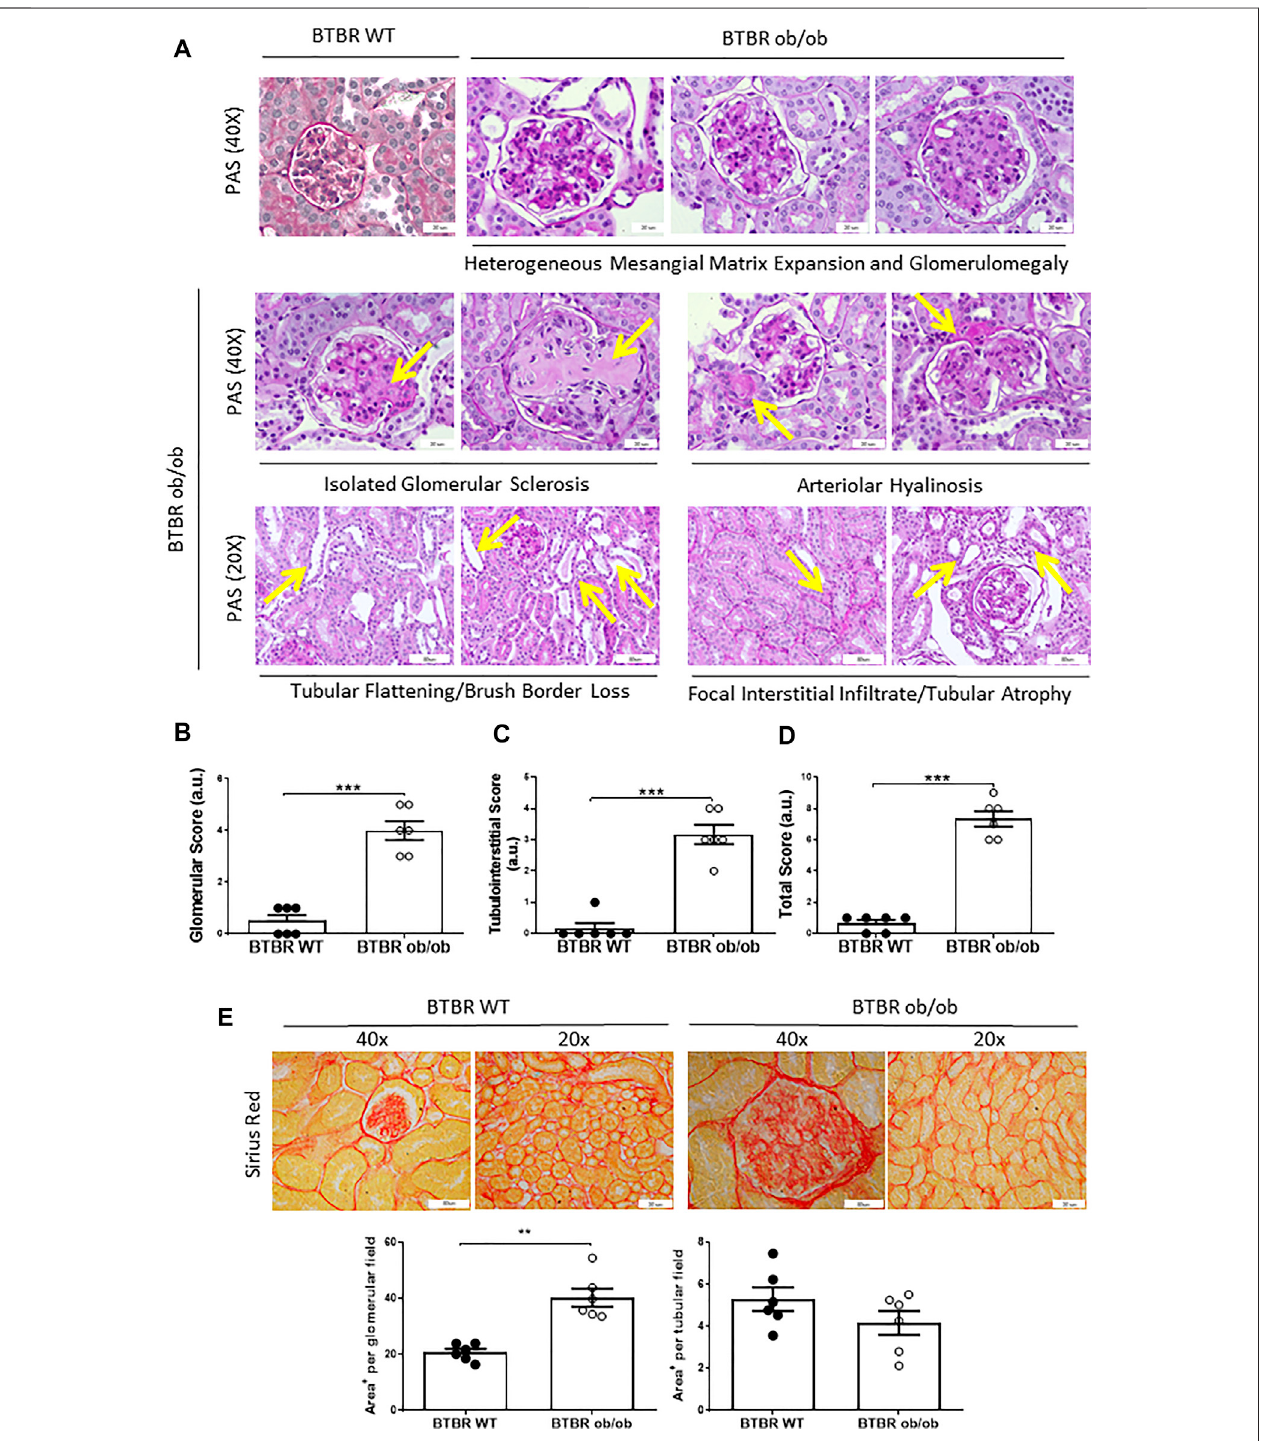
FIGURE 1 | The glomerular and tubulointerstitial features observed in BTBR ob/ob of 22 weeks old and histopathological assessment. (A) Representative images of the kidney PAS staining at different magni fi cations showing the main glomerular (yellow arrows) and tubulointerstitial (green arrows) changes detected. The histopathological assessment was evaluated in glomerular (B) , tubulointerstitial (C) , and total score (D) . (E) Representative images of the kidney Sirius red staining at different magni fi cations (upper) and their quanti fi cation (lower). Data are shown as mean ± SEM and graphs bar with scatter dot plots of each group ( n = 6 mice/ group); *** p < 0.001vs. BTBR WT. ** p < 0.005 vs . BTBR WT. a.u., arbitrary units.